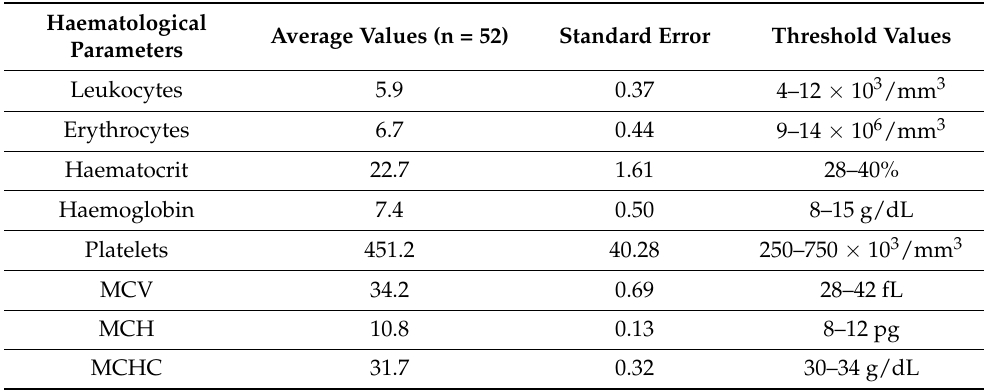
Table 6. Average values of the haematological analysis performed in sick animals. Measured parameters were leucocytes, erythrocytes, haemoglobin, haematocrit, platelets, mean corpuscu- lar volume (MCV), mean corpuscular haemoglobin (MCH) and mean corpuscular haemoglobin concentration